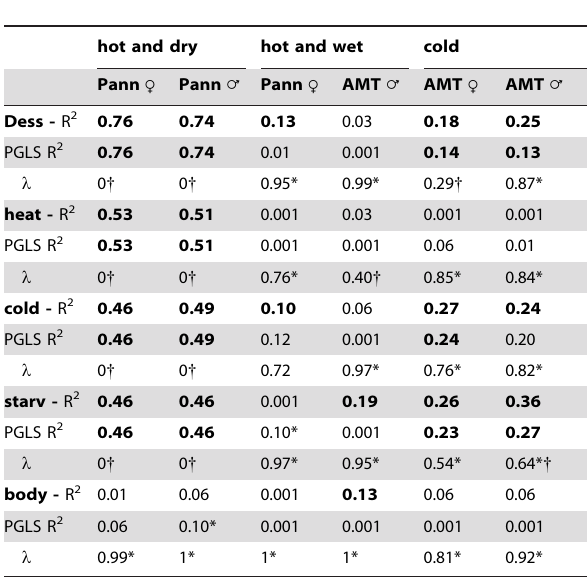
Table 2. Relationship between environmental variables and stress traits, desiccation (dess), heat, cold and starvation (starv) resistance as well as body size (body) with species divided into the three environments: warm and dry, warm and wet, and